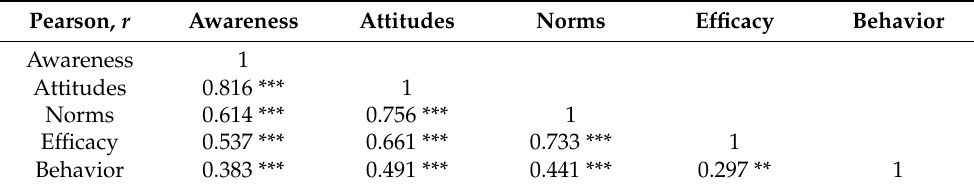
Table 8. Correlations among constructs for Experimental Group (pre-test). Pearson, r Awareness Attitudes Norms Efficacy Behavior Awareness 1 Attitudes 0.651 *** 1 Norms 0.485 *** Efficacy